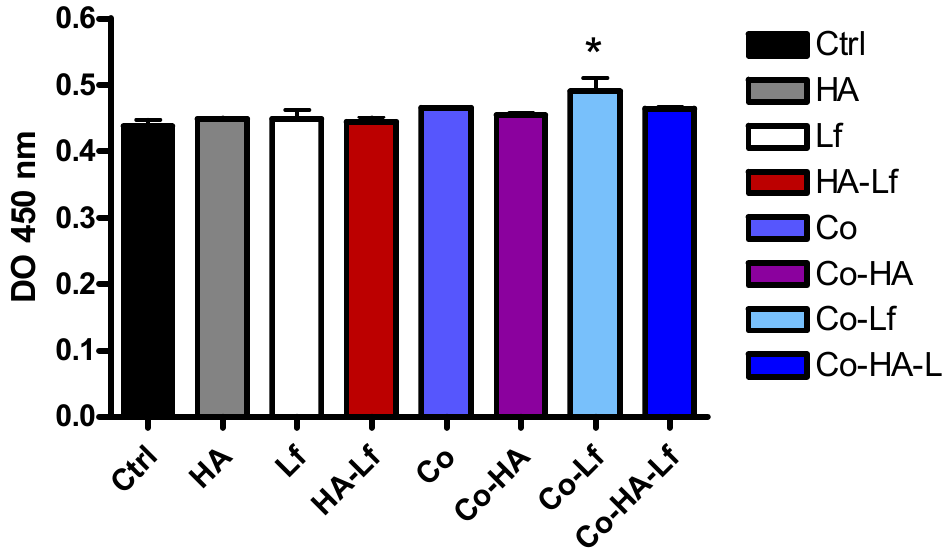
Figure 6. Viability / proliferation of human Mesenchymal stem cells (hMSCs) cultured in direct contact with analysed samples for three days as determined by MTS assay. Data analysis was based on mean ± SD (n = 3). * p < 0.05 versus control.